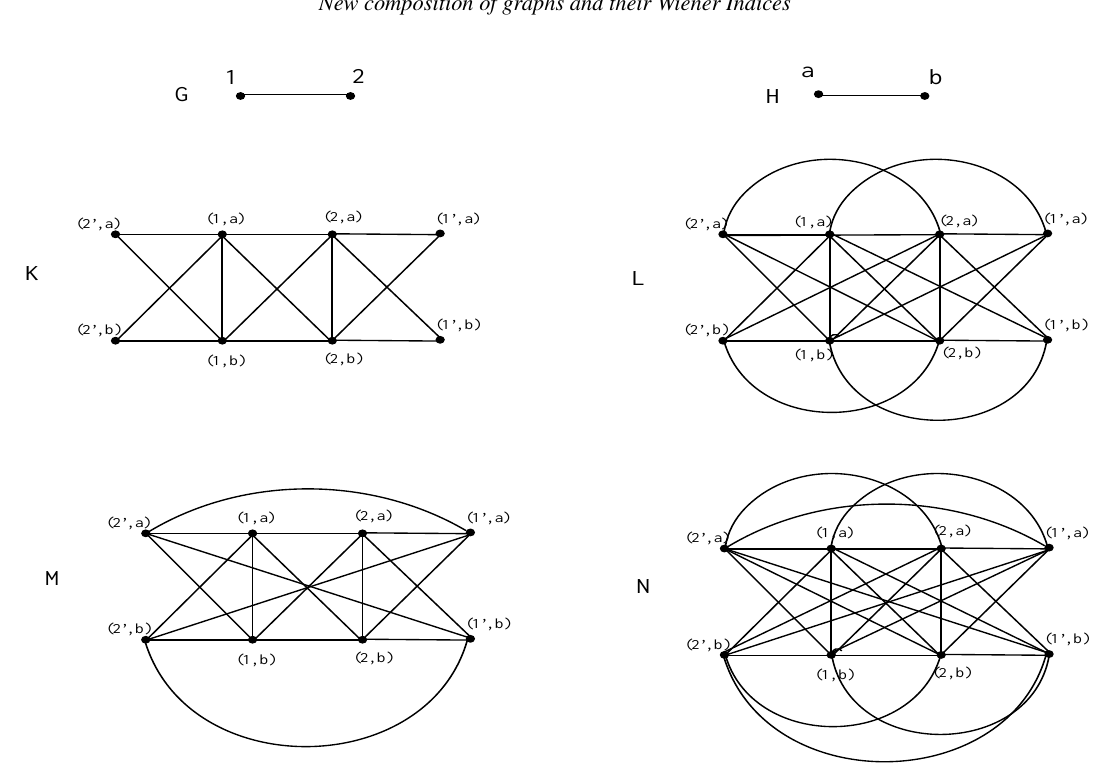
Fig. 5 The graphs G , H , P = Λ ( G )[ H ] , Q = Λ [ G ][ H ] , R = D 2 ( G )[ H ] and S = D 2 [ G ][ H